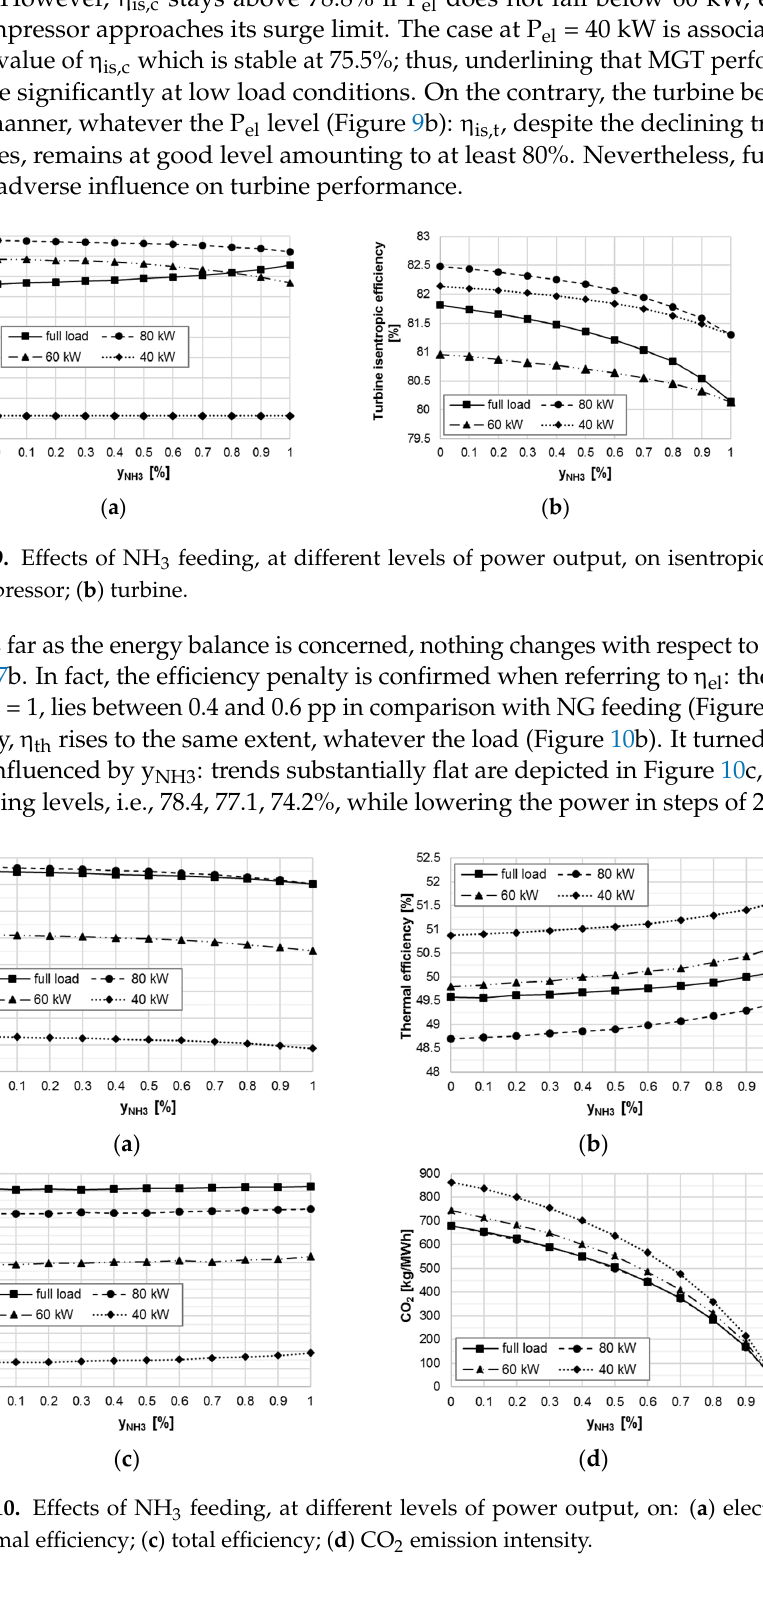
Figure 10. Effects of NH 3 feeding, at different levels of power output, on: ( a ) electric efficiency; ( b ) thermal efficiency; ( c ) total efficiency; ( d ) CO 2 emission